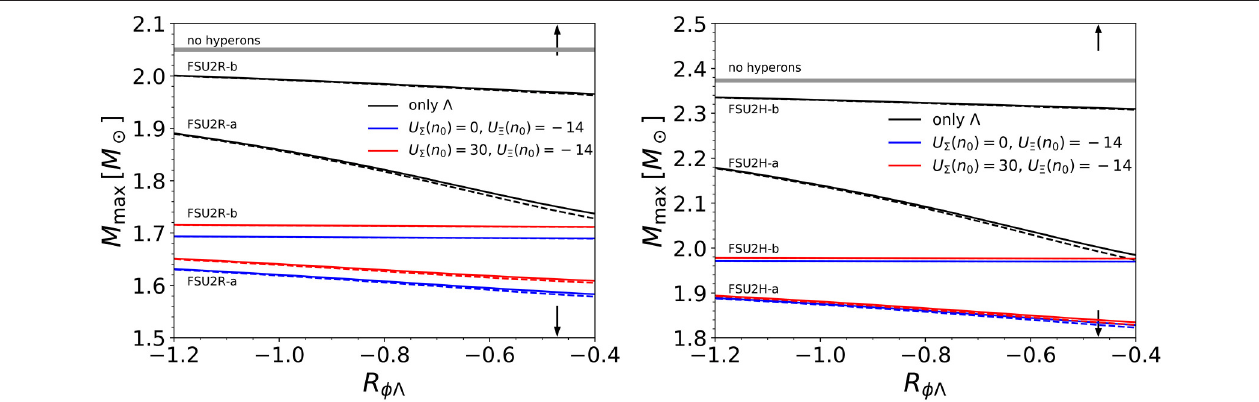
FIGURE 1 | NS maximum mass M max as a function of R φ3 for FSU2R (Left) and FSU2H (Right) and hyperonic models -a and -b. The values R σ3 and R σ * 3 are adjusted to reproduce the binding energies of single 3 -hypernuclei and of 6 33 He with 1 B 33 of R ω3 and R φ3 . The arrows indicate R φ3 ( SU (6)). See text for details.